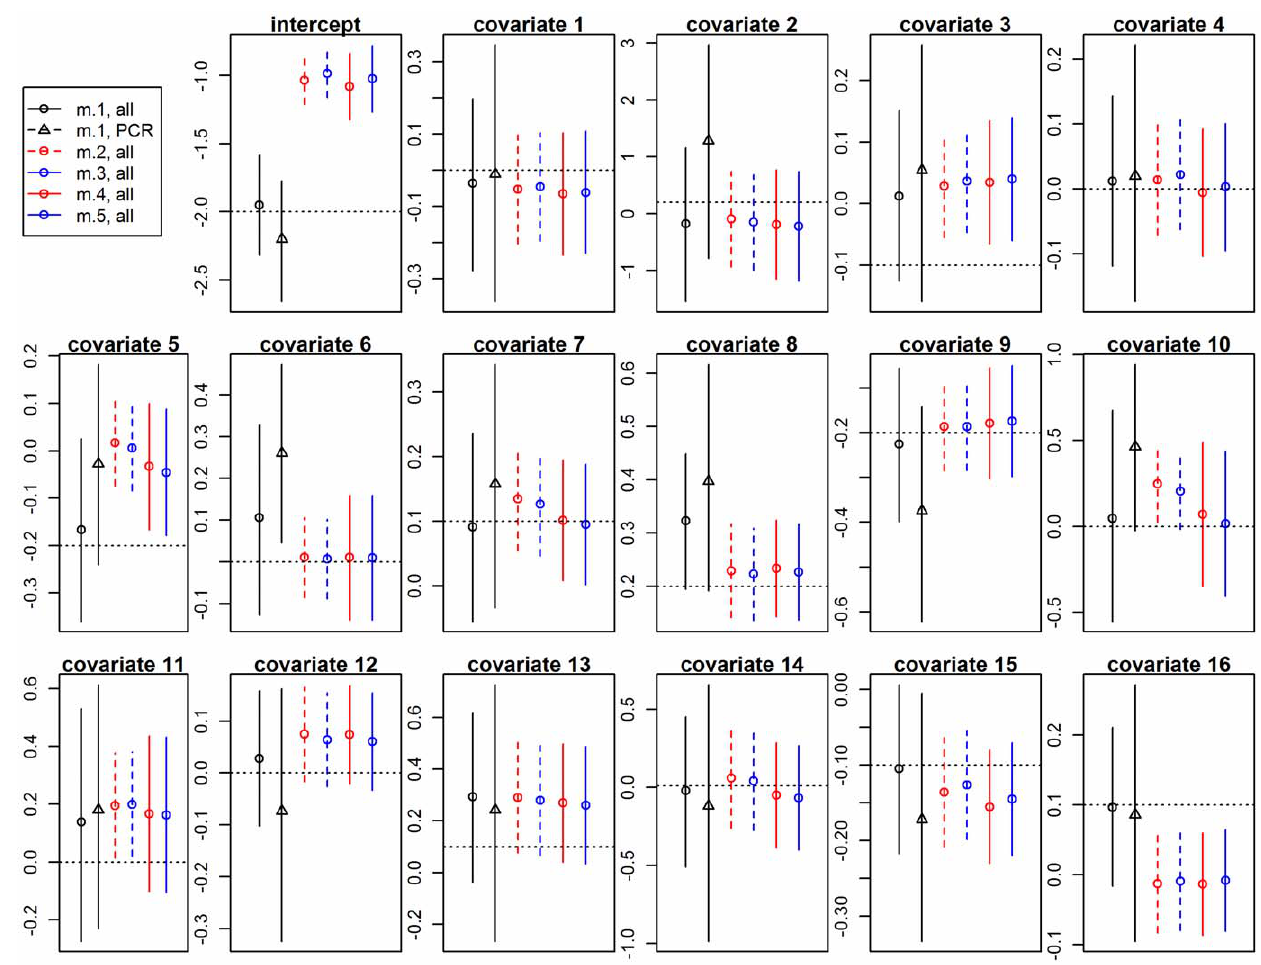
Figure 2. Comparison of models using simulated data. The true values of the infection risk factor parameters are depicted in horizontal black dashed lines. Logistic regression models with disease (models 2 and 4) and infection (models 3 and 5) as response variables are depicted in red and blue, respectively. Models with and without random effects are depicted with continuous and dashed vertical lines, respectively. Models 2–5 were fitted to all datasets. Model 1 was fitted twice, once for just the PCR dataset (black triangle) and once for all datasets (black circle). Details of these models are given in Table 2.